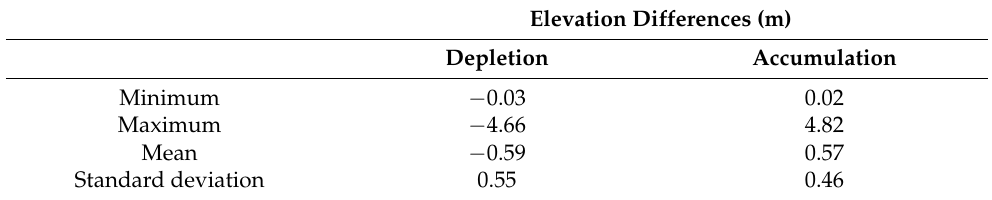
Figure 9. Elevation differences map within the Vomice landslide area, calculated by the subtraction between the 2019 and 2022 DTMs. Table 4. Summary statistics of elevation differences between February 2019 and June 2022 DTMs.